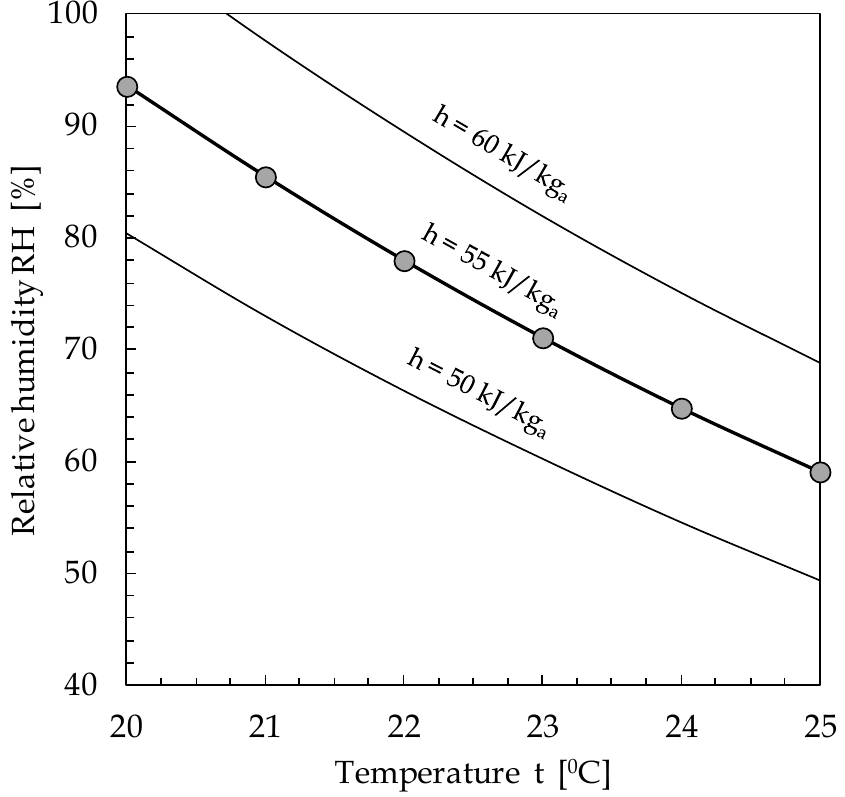
Figure 5. Indoor environmental optimal pairs of t and RH for coronaviruses viral load inactivation.